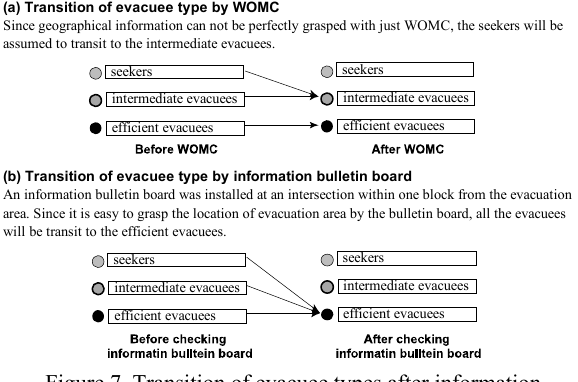
Figure 7. Transition of evacuee types after information acquisition